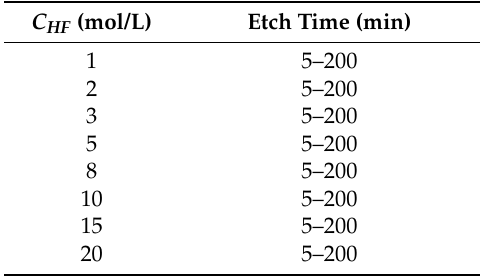
Table 1. Etching conditions of MAS in HF